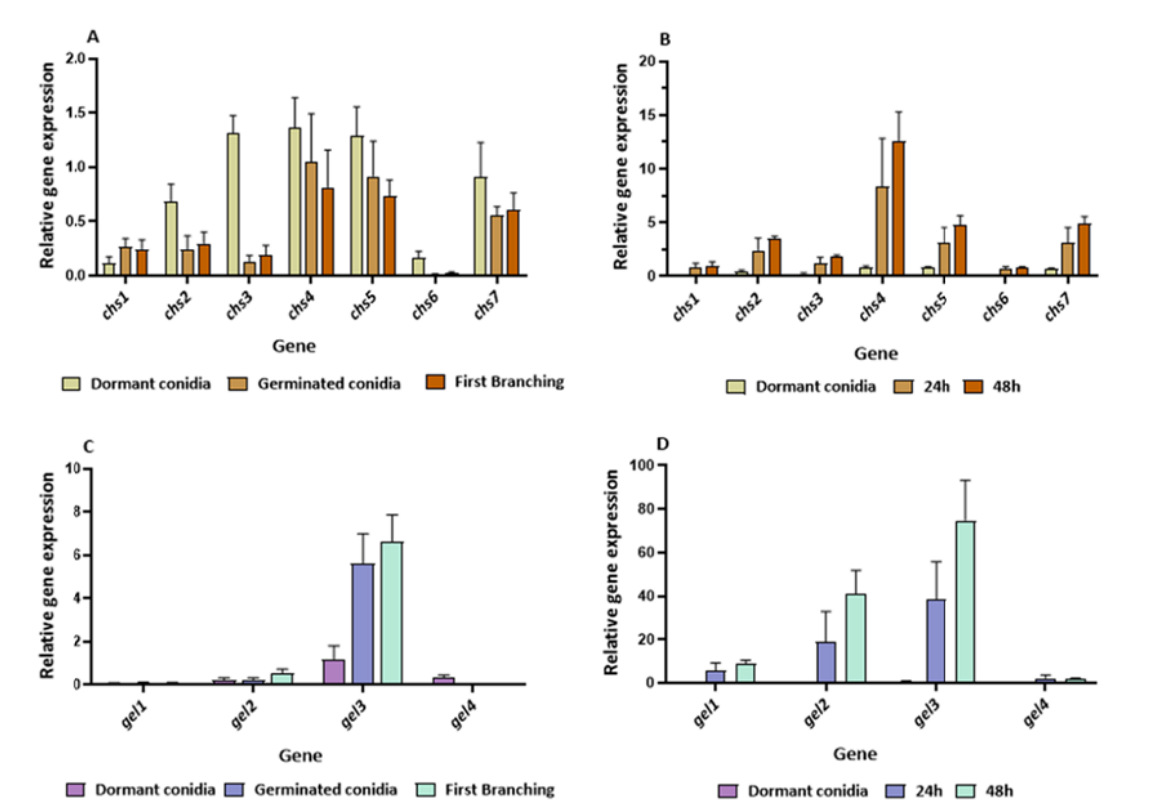
Figure 11. Expression levels of chs1 – chs7 during germination ( A ) on solid medium or ( B ) on the host Rhizoctonia solani. Expression levels of gel1 – gel4 genes during germination ( C ) on solid medium or ( D ) on the host R. solani . Gene expression was determined by RT-PCR. Values shown are based on three biological repeats, with whiskers signifying one standard error. Gene expression was normalized to tef1 . The threshold cycle (2 −ΔΔCT ) method was used to determine fold changes in expression.